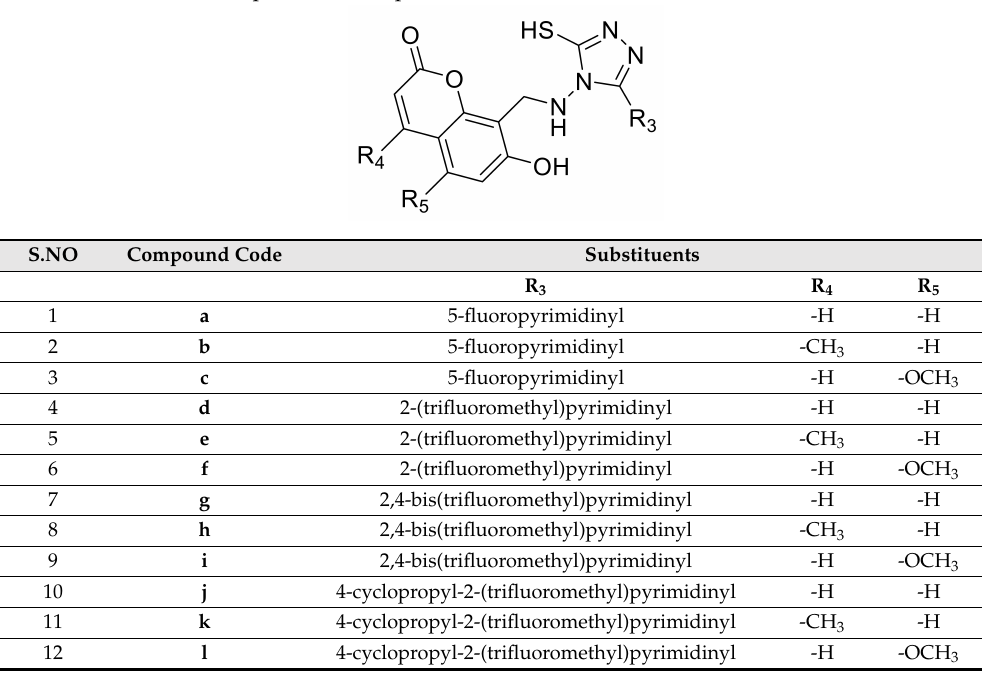
Table 4. Structures of the predicted compounds a–l .